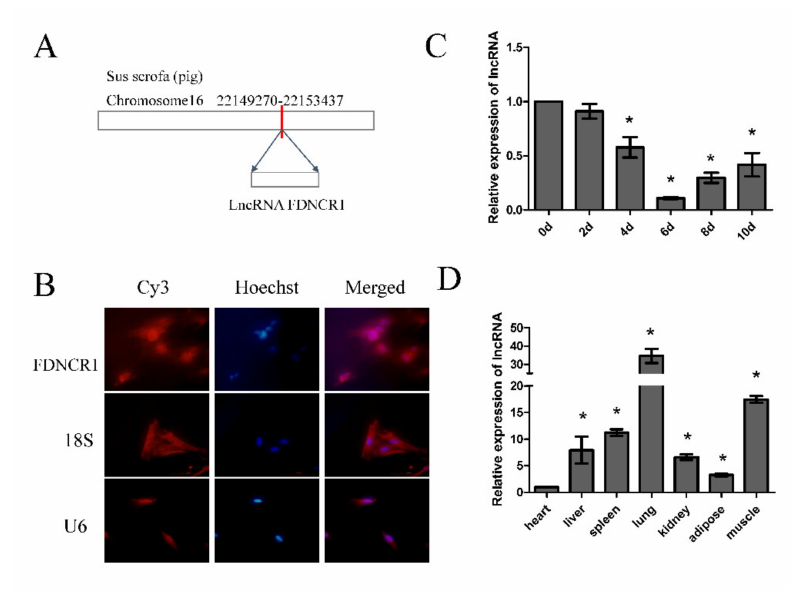
Figure 3. Characterization of fat deposition-associated long noncoding RNA1 (FDNCR1) in porcine preadipocytes. ( A ) Locations of FDNCR1 on pig chromosomes. ( B ) FISH detection of the lncRNA localization in preadipocytes. ( C ) Expression of FDNCR1 at di ff erent developmental stages. ( D ) Expression of FDNCR1 in di ff erent tissues. “*” indicates significance.